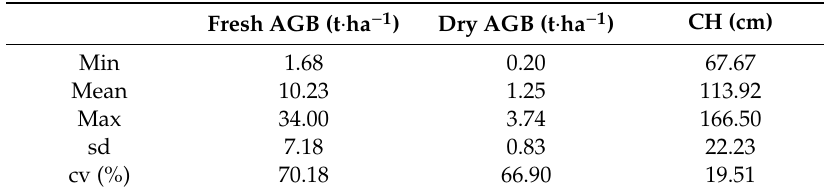
Table 2. Statistical summary of the in-situ measured crop above-ground biomass (AGB) (t · ha − 1 ) and crop height (CH) (cm) (n =